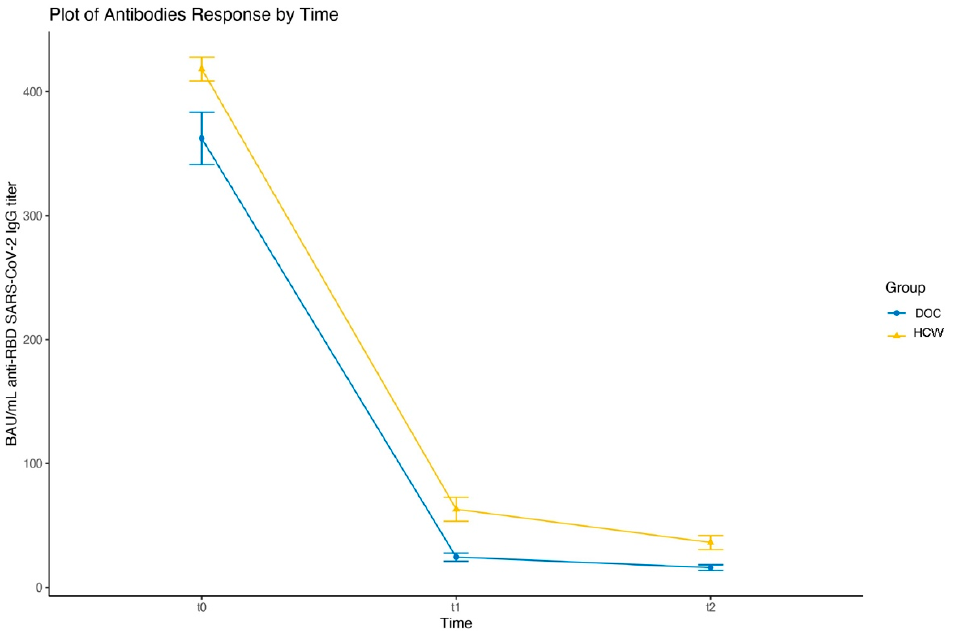
Figure 1. Mean antibody responses over the three timepoints in DOC patients and healthcare workers (HCW) after completion of regime vaccination with two doses of BNT162b2.